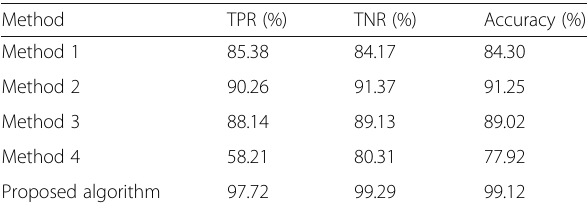
Table 1 Performance comparison between the proposed algorithm and the existing